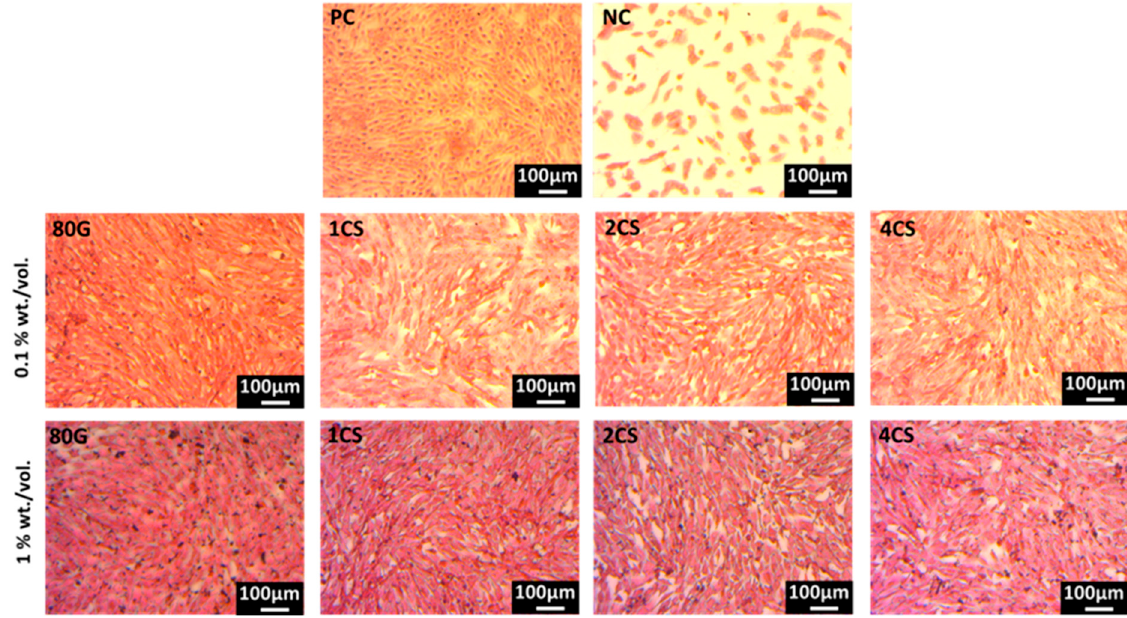
Figure 10. H&E-stained images of MG-63 cells cultured with 0.1 and 1 wt./vol.% extract of MBG along with positive control (PC) and negative control (NC). along with positive control (PC) and negative control